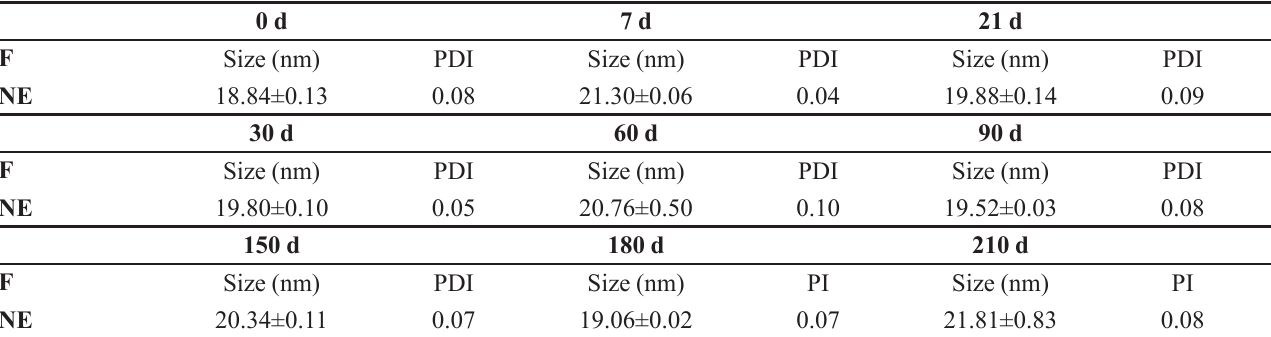
TABLE III - Stability data of the nanoemulsion (NE)